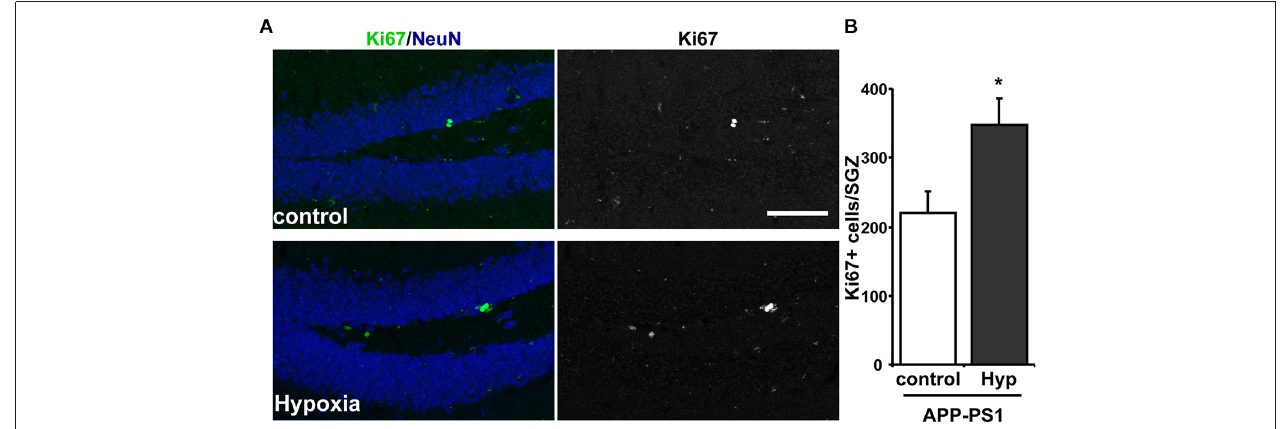
50 µ m. (B) Quantification of total number of Ki67 positive (Ki67 + ) cells in the SGZ of APPswe-PS1 (cid:49) E9 mice maintained in control conditions or exposed to hypoxia for 72 h. Bars represent mean ± S.E ( n = 3 mice). * p < 0.05.